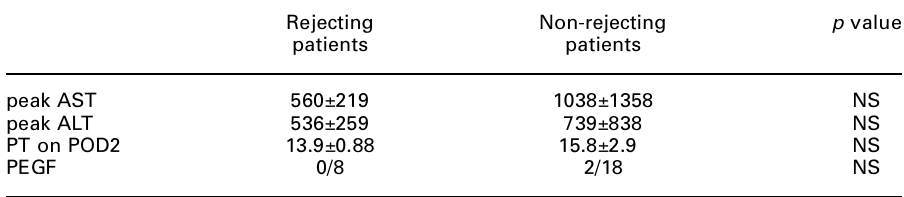
Table 1. Early graft function in liver transplant patients